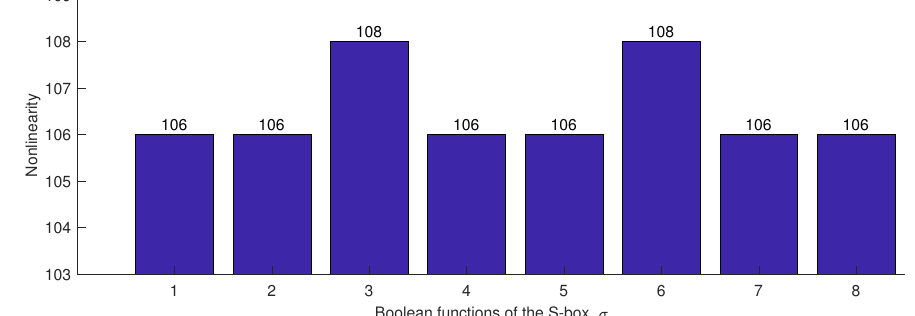
Figure 4. The NLs of each Boolean function of the newly designed S-box σ .